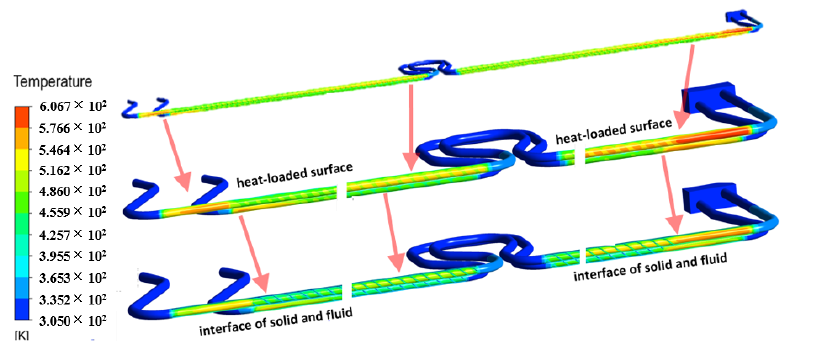
Figure 7. Temperature profiles of the front and back swirl tubes.